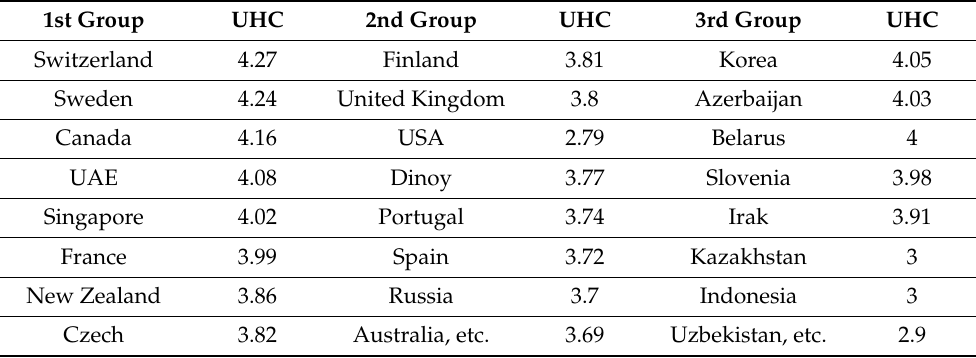
Table 8. Results of the rating of readiness for digitalization of energy of countries in three groups (developed by the